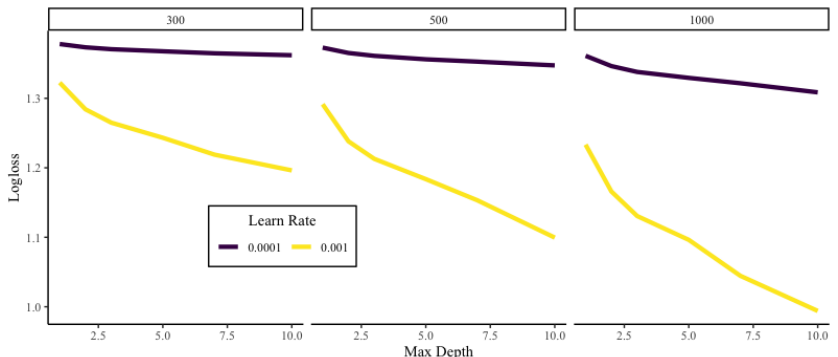
Figure 15. Visualization of the results from tuning gradient boosted forests to predict claim frequency on the COLL data. Here, we show the change in logloss across different values of max depth of each tree in the gradient boosted forest. The left pane shows the results when the number of trees is 300, the middle pane shows when the number of trees is 500, and the right pane shows the results when the number of trees is 1000. Each pane contains two lines of different colors representing different learning rates.